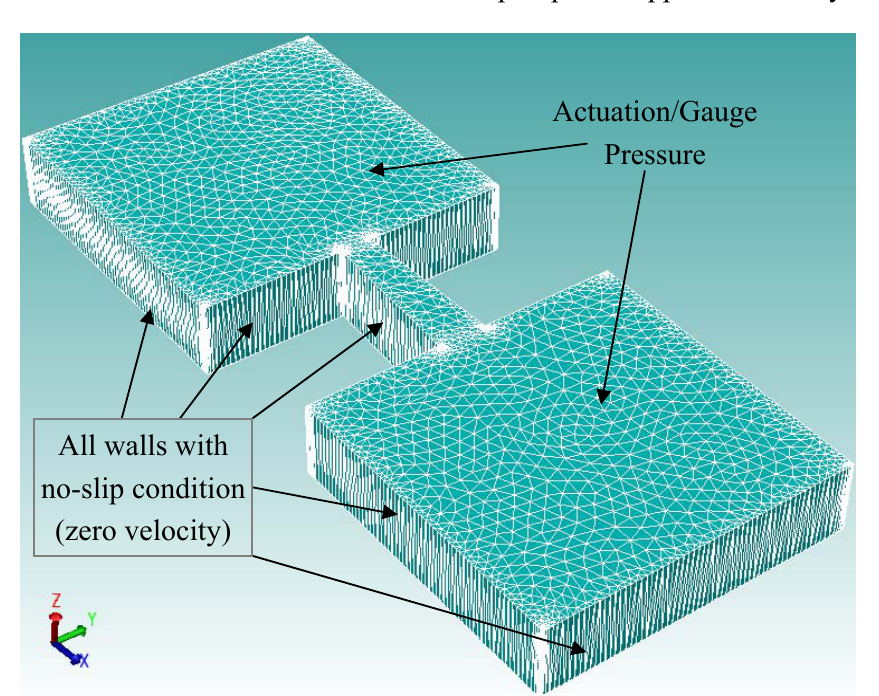
Figure 4. Meshed model of the valveless micropump with applied boundary